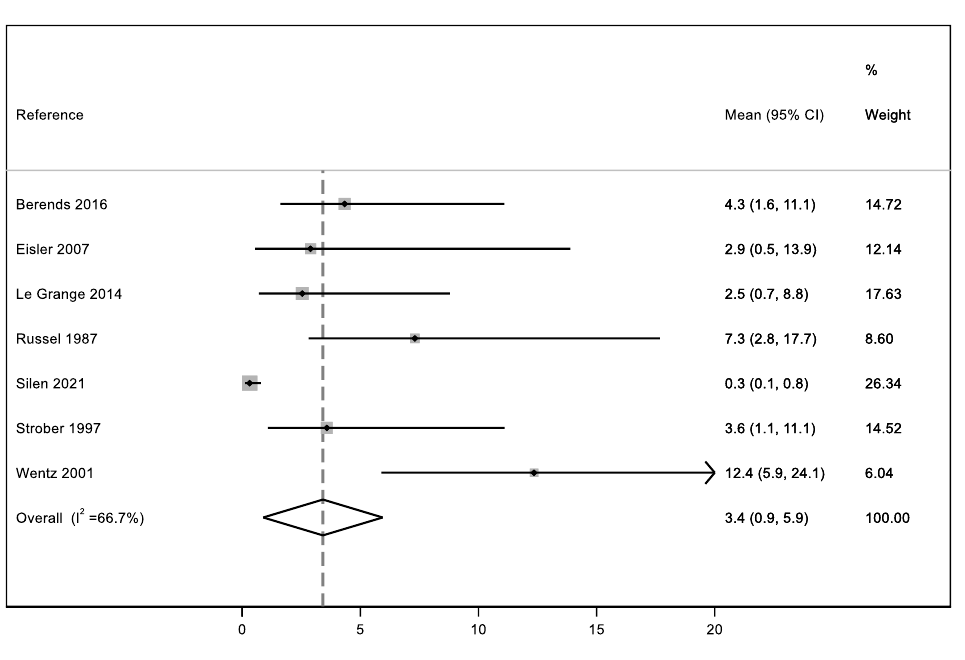
Table 2. Studies included in the qualitative analysis of medical and psychiatric comorbidities and substance use in EDs and associated social – relational complications.